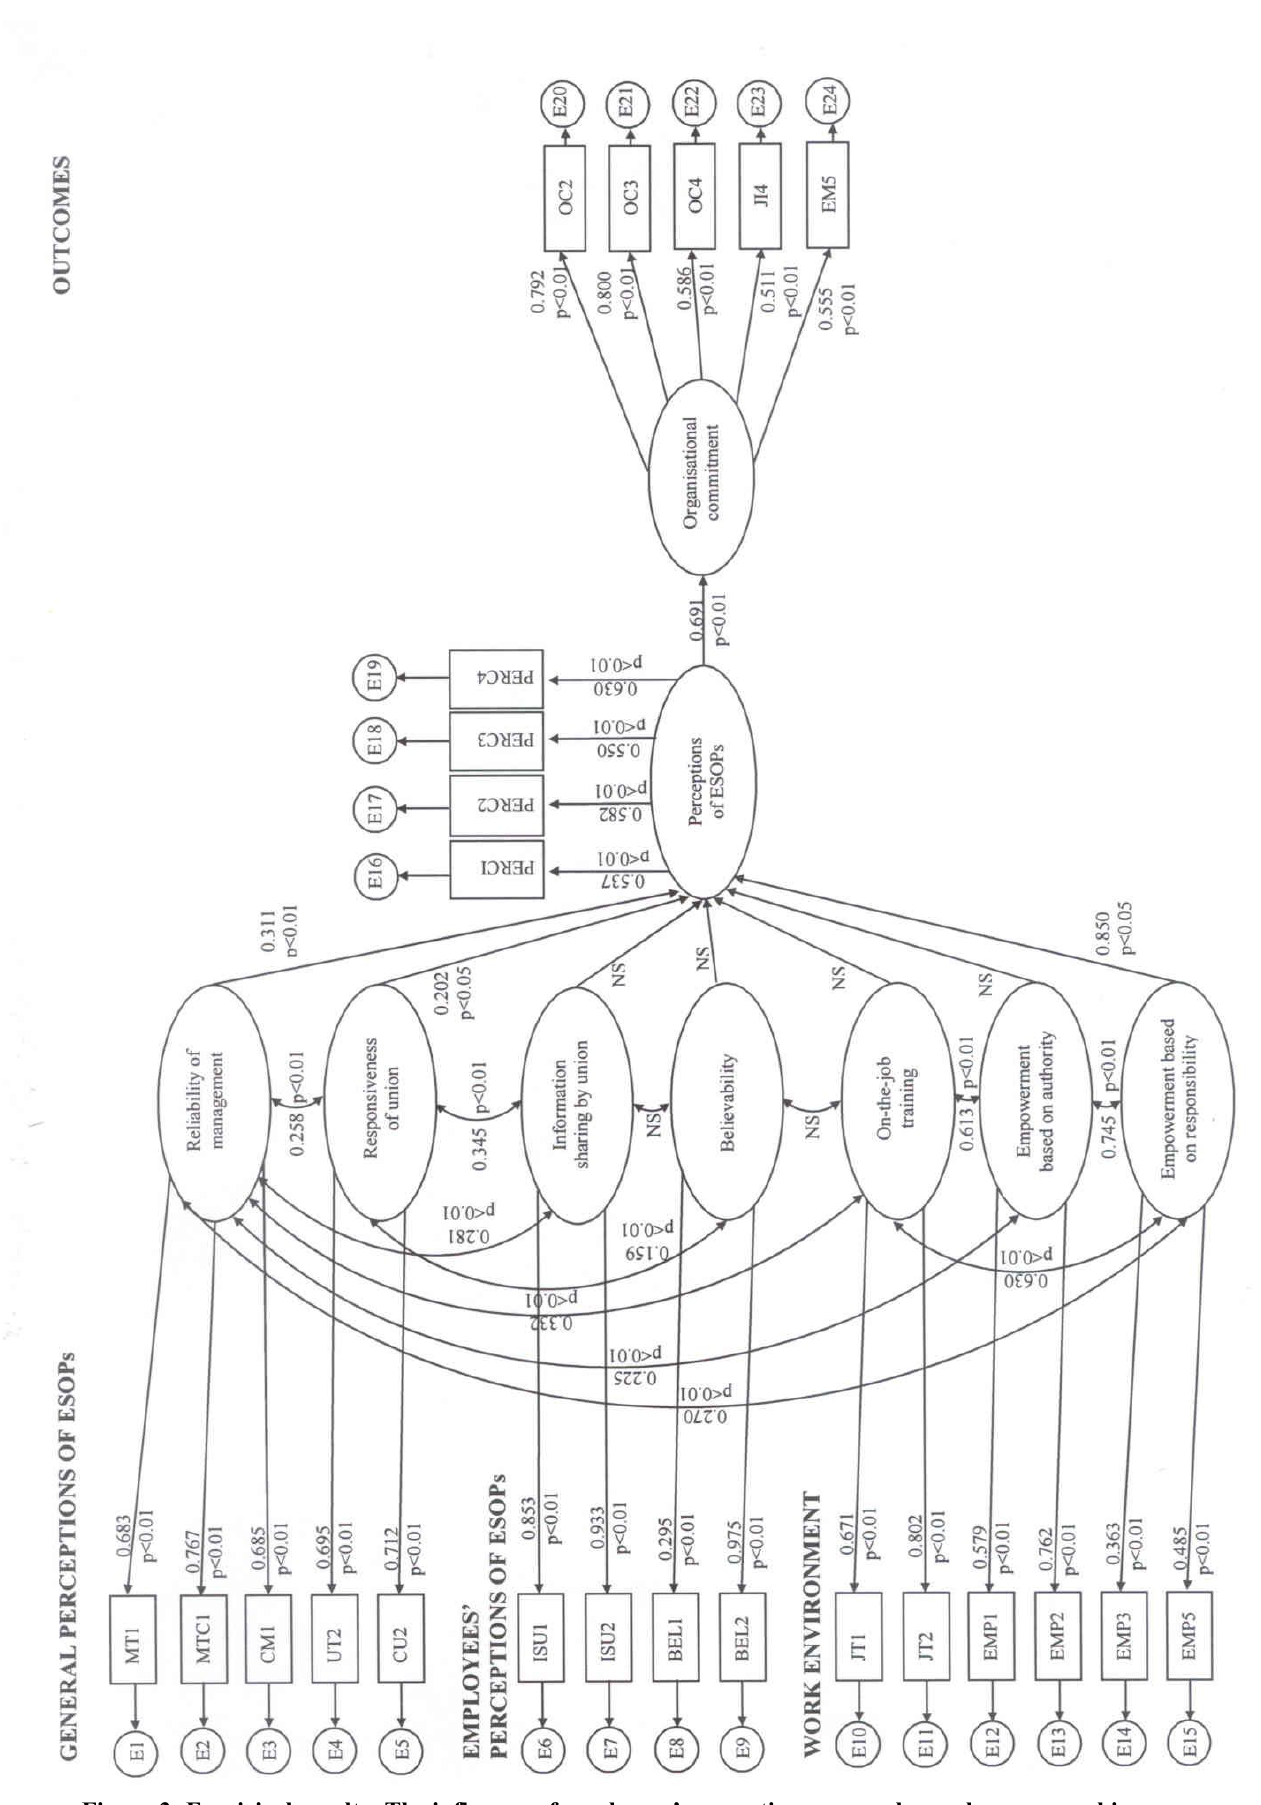
Figure 3: Empirical results: The influence of employees’ perceptions on employee share ownership schemes